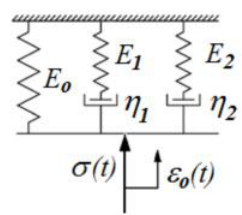
Figure 6. Five-parameter rheological